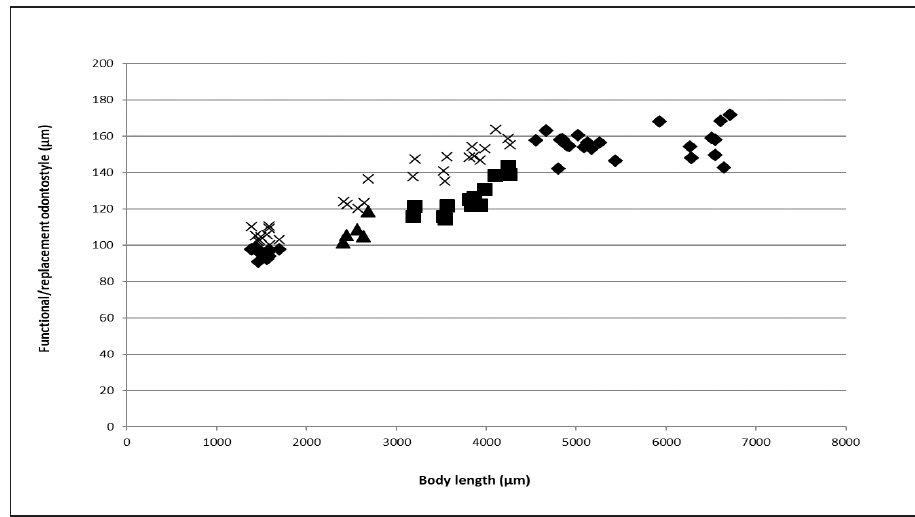
Figure 5. Scatter plot of odontostyle (  ,  ,  ) and replacement odontostyle (×) against body length of Longidorus cheni sp. n. juveniles (J1 to J3) and (  )